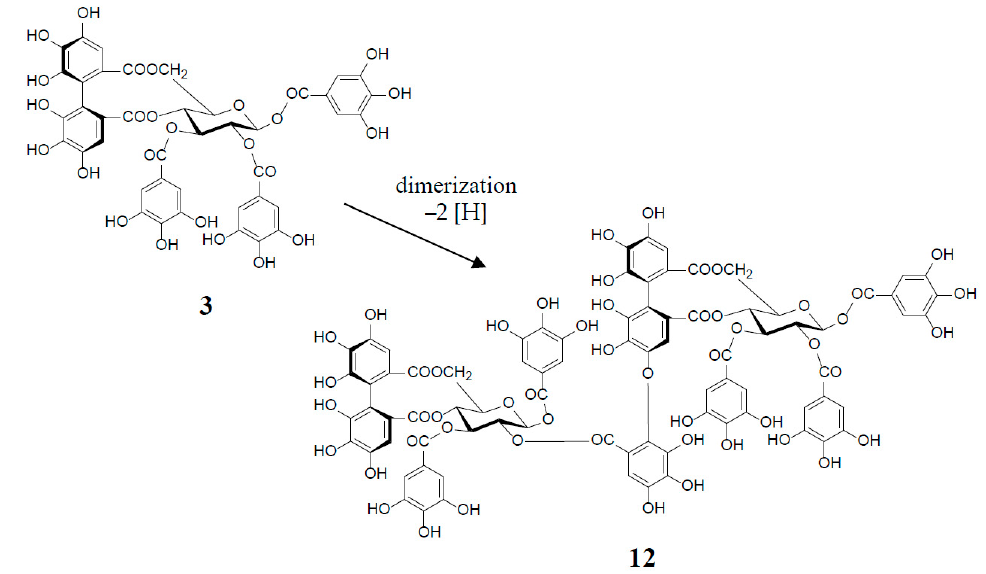
Figure 3. In vitro biosynthesis of cornusiin E ( 12 ) from tellimagrandin II ( 3 ) (2